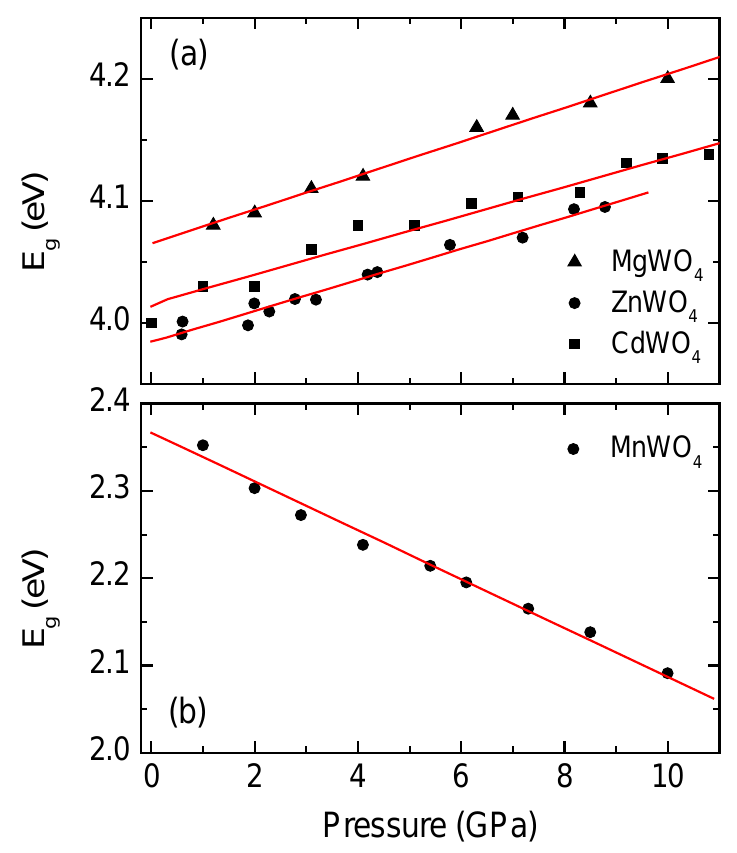
Figure 7. Pressure dependence of the band-gap energy in ( a ) wolframite-type MgWO 4 , ZnWO 4 , CdWO 4 , and ( b ) MnWO 4 .